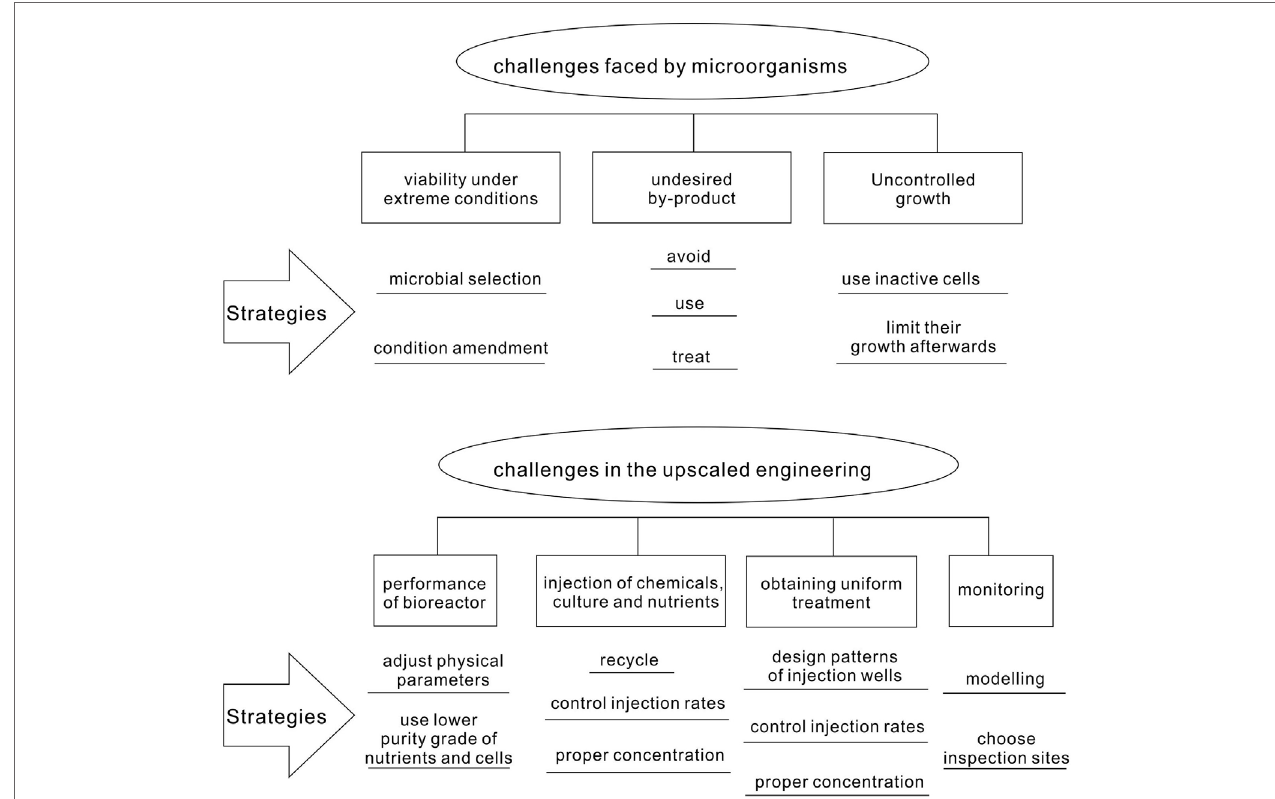
FiGURe 6 | Challenges faced in the real application of microbial carbonate